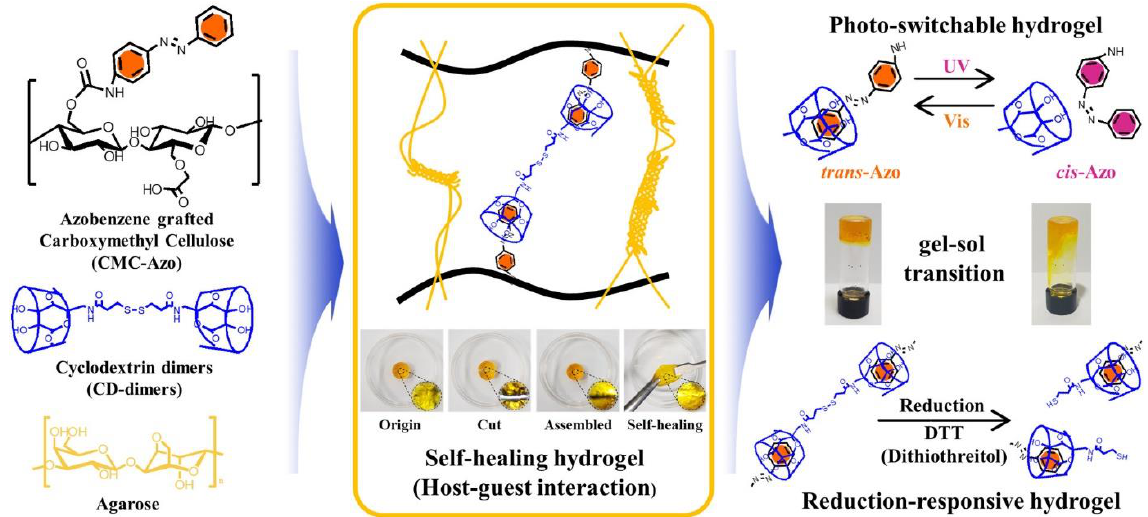
Figure 13. Photo-switchable, reduction-responsive, and self-healing CMC-Azo hydrogels based on host-guest interactions with CD-dimers. Reuse (reprint) with permission of Kim, Y.; Jeong, D.; Shinde, V.V.; Hu, Y.; Kim, C.; Jung, S. Azobenzene-Grafted Carboxymethyl Cellulose Hydrogels with Photo-Switchable, Reduction-Responsive and Self-Healing Properties